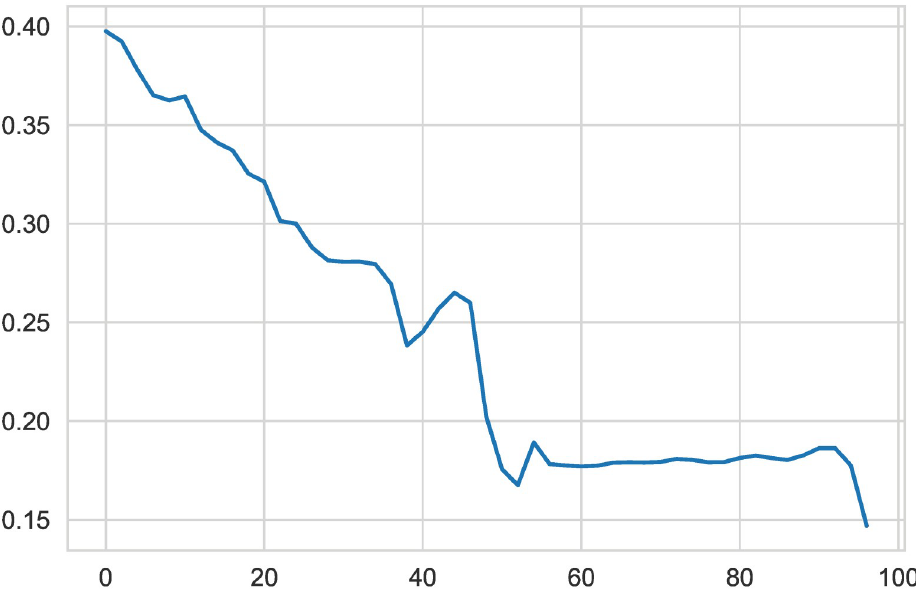
Fig 11. Centroid undersampling for NB. Without undersampling, the highest F2-score is 0.3975. Continuously increasing the undersampling rate does not blindly reduce the evaluation score. It is non-decreasing but increases when the undersampling rate is approximately 54% and